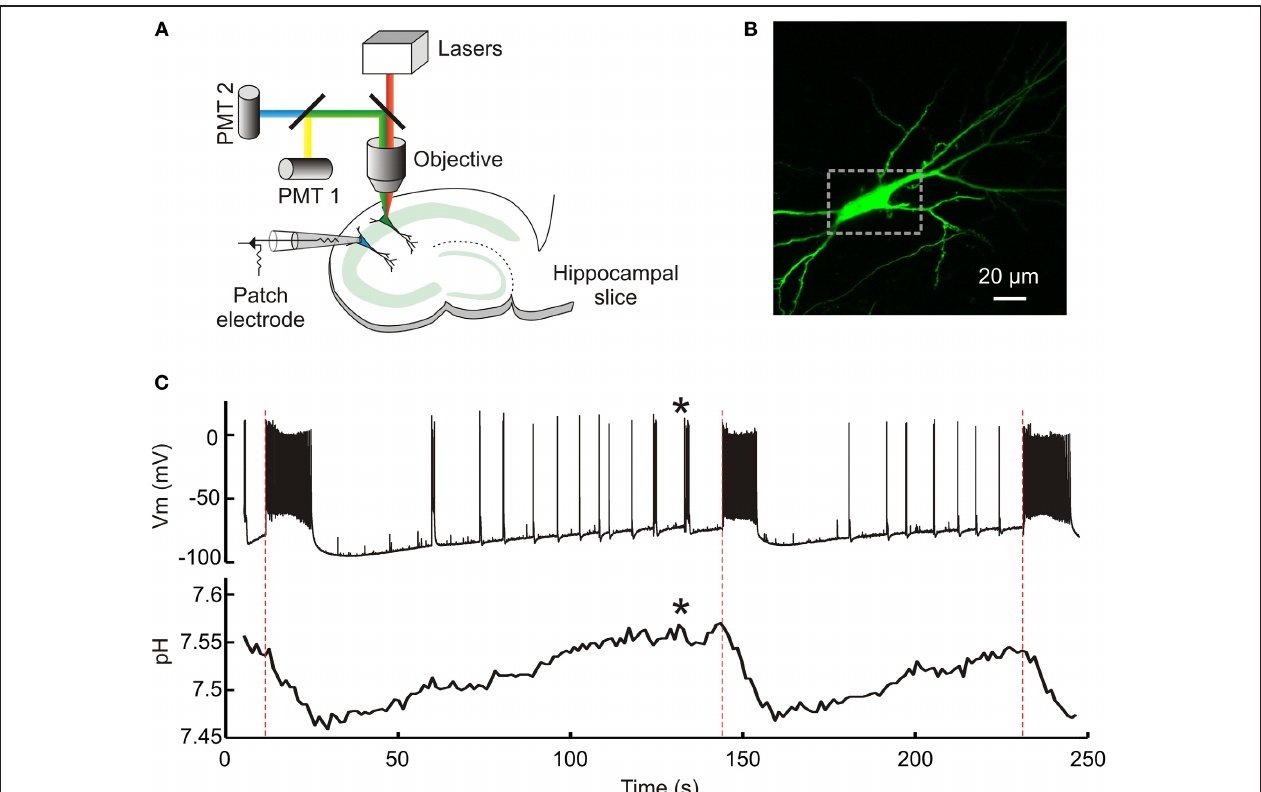
FIGURE 1 | Genetic reporters of pH detect intracellular pH changes during epileptiform activity. (A) A schematic of the experimental setup. A hippocampal pyramidal neuron transfected with a genetically encoded pH indicator was imaged using either two-photon or single-photon confocal microscopy. This allowed dynamic measurement of intracellular pH. A whole-cell patch recording from a neighboring neuron (cell somata < 200 µ m apart) provided simultaneous readout of seizure activity within the hippocampal slice. (B) A confocal image of a CA3 pyramidal neuron expressing the pH indicator E 2 GFP. The dashed rectangle demarcates the